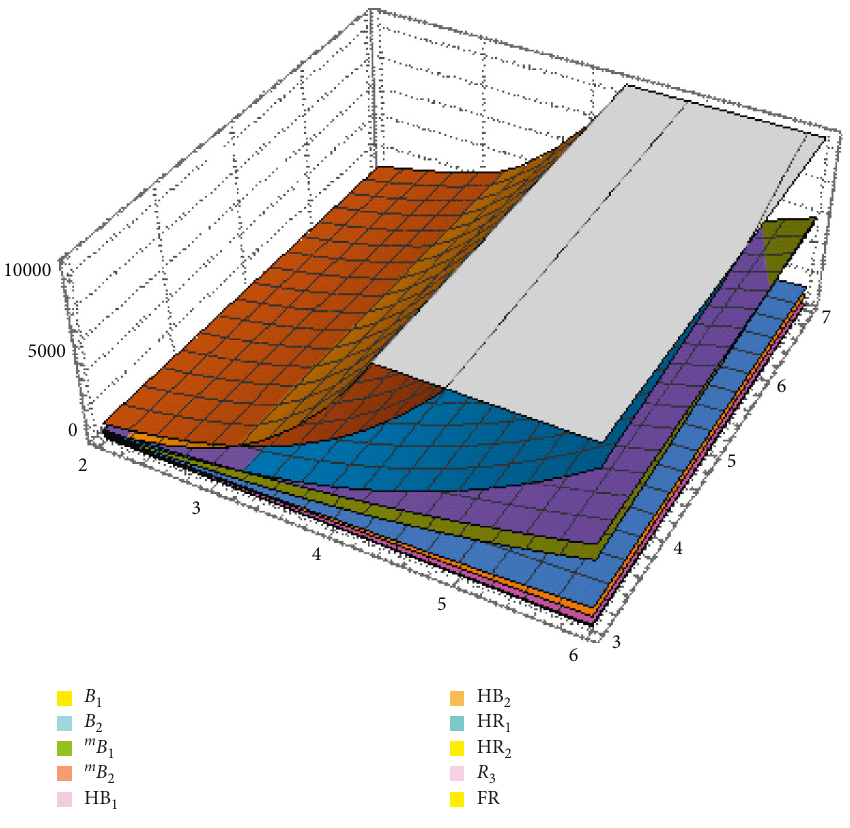
Figure 3: Comparison of topological